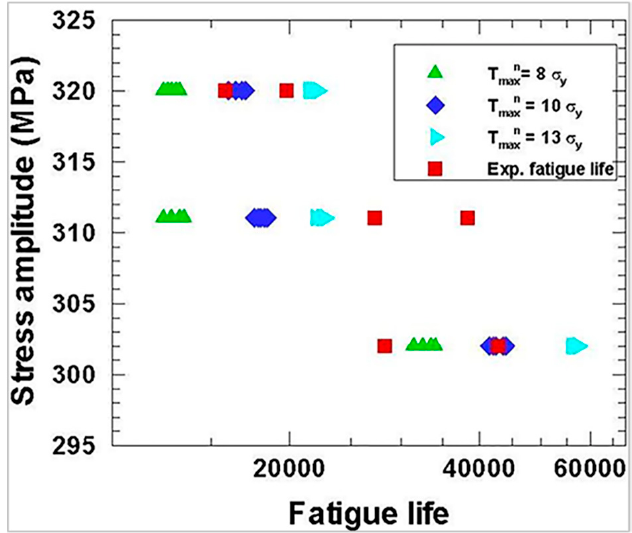
Figure 6. Cohesive strength effects on the fatigue life. Table 2. Material parameters for the CG and SMATed 304 SS.